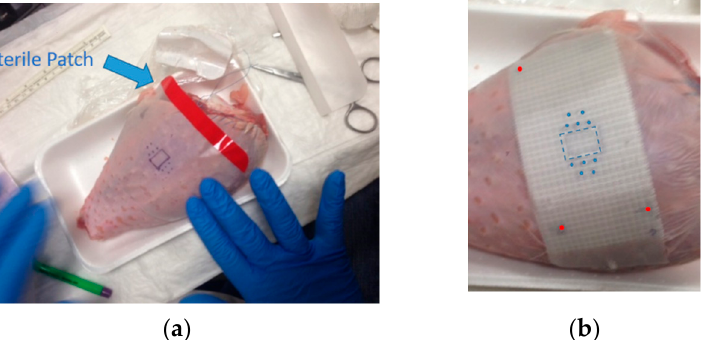
Figure 3. ( a ) Phantom lesion is contoured by the physician with surgical blue ink and a transparent sterile patch is superimposed (indicated in figure by the blue arrow). ( b ) Adhesive fiberglass mesh is applied over the patch in order to re-draw the lesion with radio-opaque ink (marked in blue) and the localization points used as reference points (marked with red dots).